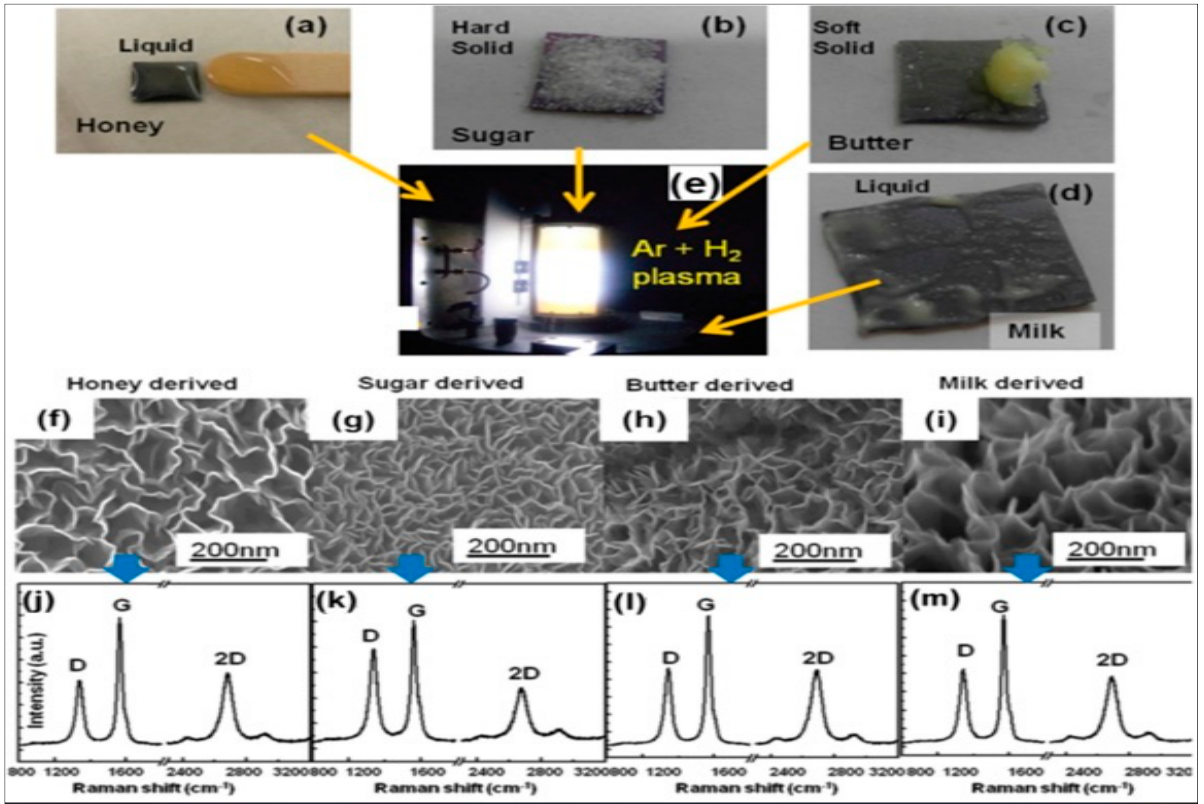
Figure 6. Synthesis and characterization of graphene nano-sheets via plasma-based technique with natural precursors. Images of natural antecedents in various stages placed on pure SiO 2 substrates, and ( e ) the plasma used to make vertical graphene ( a – d ). SEM and Raman spectra of fabricated Graphene nano-sheets fabricated using ( f , j ) honey, ( g , k ) sugar, ( h , l ) butter, and ( i , m ) milk. (Reprinted with permission from [140] John Wiley and Sons, License No. 5399130576609).